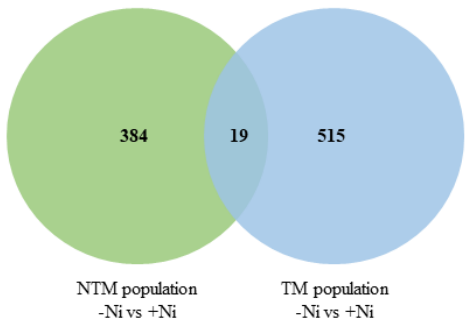
Figure 3. Venn diagram of differentially expressed genes in roots of two Noccaea goesingensis ecotypes treated with 150 µM Ni for 21 days. Differential genes expression was evaluated by comparing gene expression profiles of plants grown in the control substrate and in Ni-enriched substrate. Green circle represents the comparison between – Ni vs. +Ni in the Flatz ecotype, blue circle – Ni vs. +Ni in the Redlschlag ecotype.